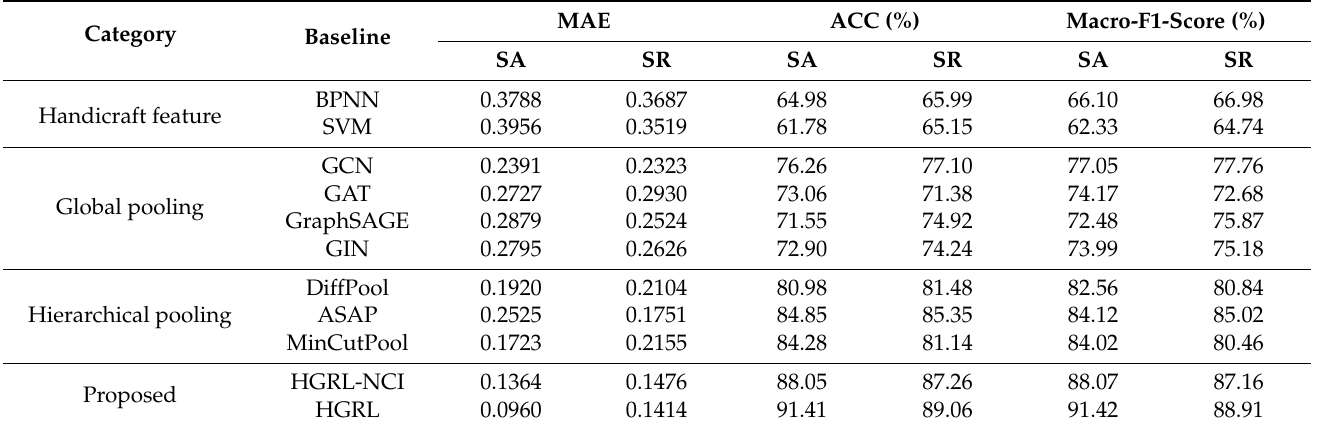
Table 5. Evaluation performance of different methods in SA and